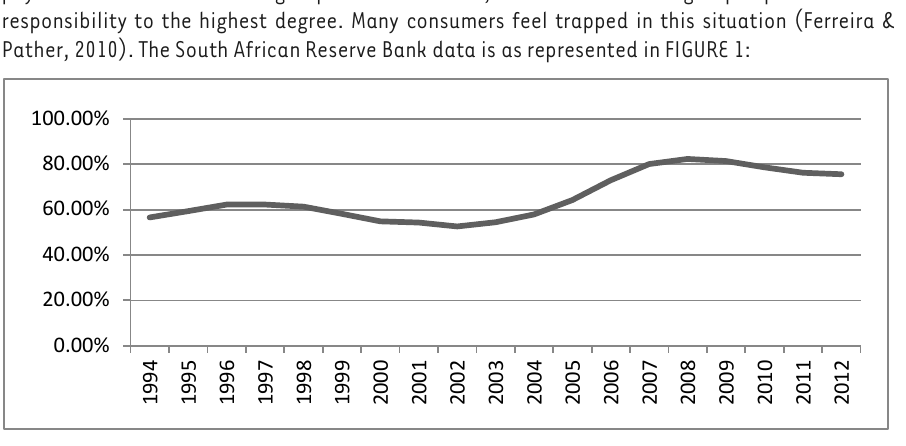
FIGURE 1: Household debt to disposable income of households in South Africa Source: South African Reserve Bank,